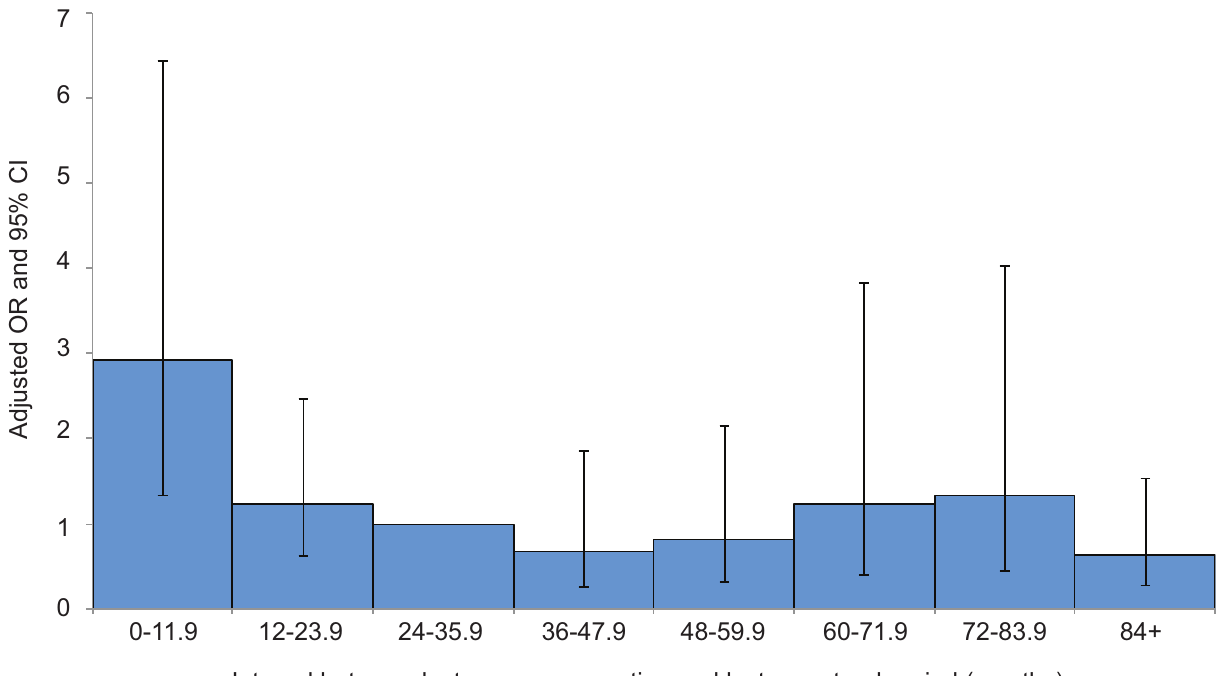
Figure 3. Risk of uterine rupture according to the interval between the last caesarean section and start of current pregnancy. Adjusted for woman’s age as a continuous linear term, ethnicity, body mass index as a continuous linear term, parity as a continuous linear term, number of previous caesarean deliveries as a continuous linear term, previous uterine surgery, placenta praevia, macrosomia, and planned mode of